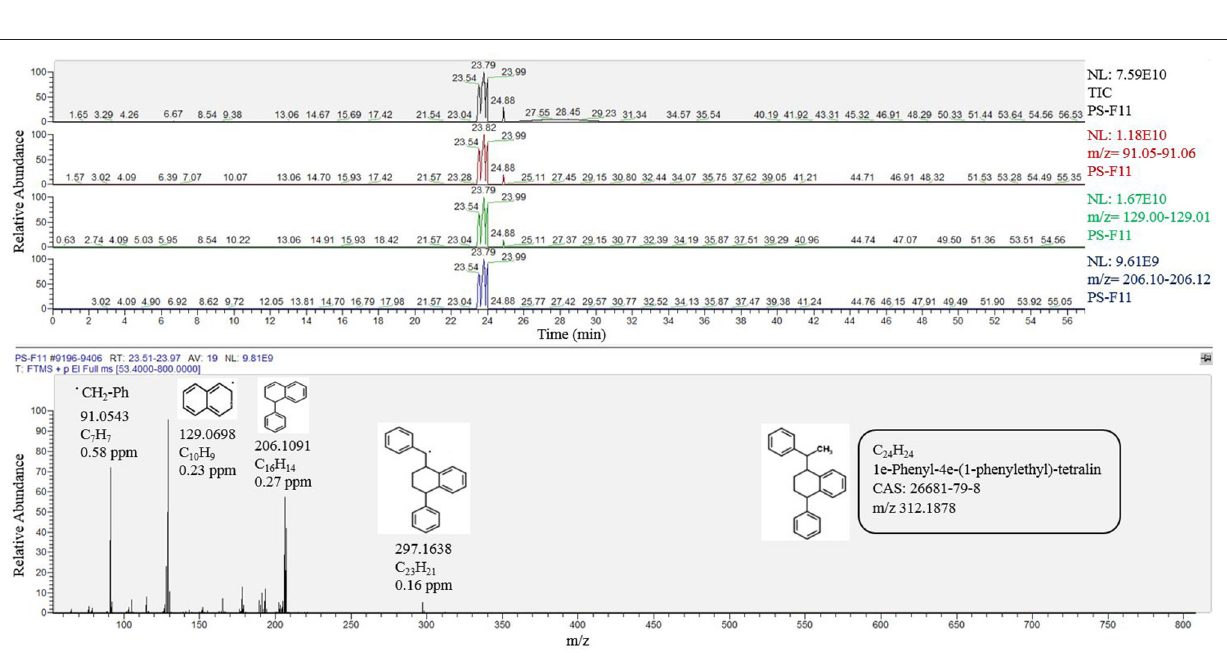
Frontiers in Environmental Science |